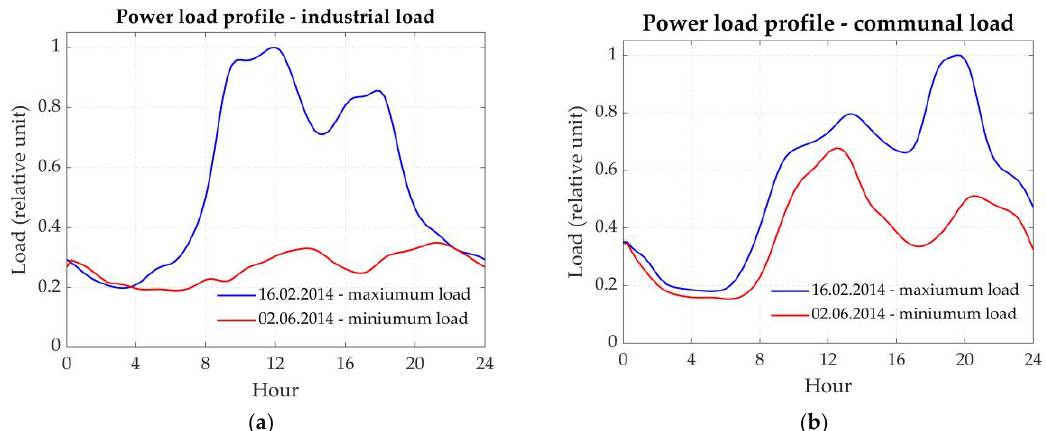
Figure 1. The 24 h load profiles for: ( a ) industrial load; ( b ) communal load, for the maximum and minimum load day in 2014.